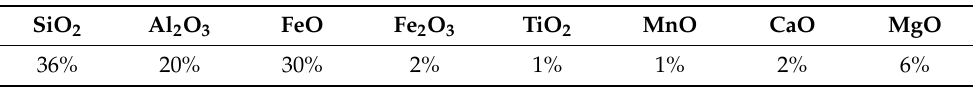
Table 5. Chemical composition of the original abrasive material according to the supplier’s list.